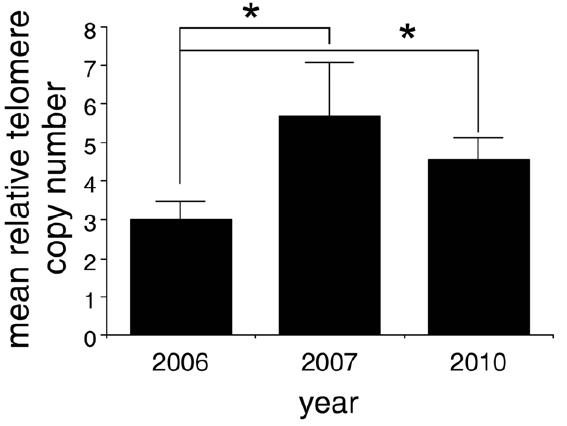
Figure 4. Relative mean DFT telomere copy number increases with time (2006: N=30, 2007: N=13 and 2010: N=8). Error bars depict standard deviations. Significant differences in telomere copy numbers (TCN) were observed between years 2006 and 2007 (P=0.03) and 2006 and 2010 (P=0.01), but no significant difference in TCN was observed between years 2007 and 2010 (P=0.6). * indicates significant differences.